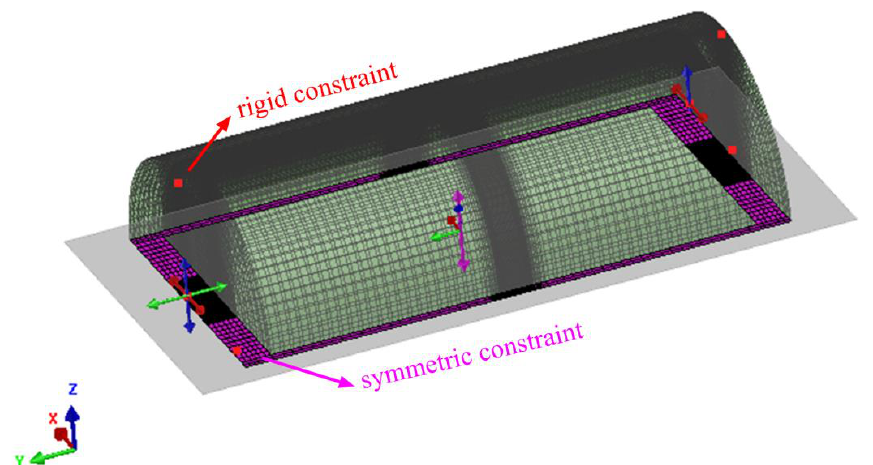
Figure 3. The half-pipe finite element model: ( a ) downside; ( b ) upside. The symmetric constraint was applied on the symmetry plane, and the rigid constraint was applied on the left and right planes, as shown in Figure 4. The pressure was applied as the experimental condition, as shown in Figure 5.